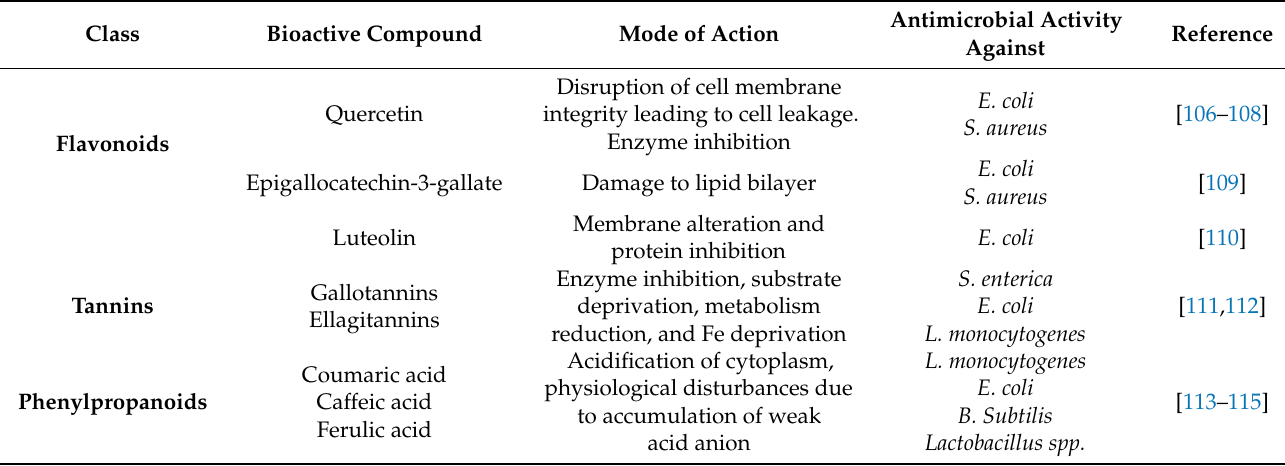
Table 1. Mode of action of phytochemicals with known inhibitory activity against enteric pathogens that caused foodborne illness from contaminated